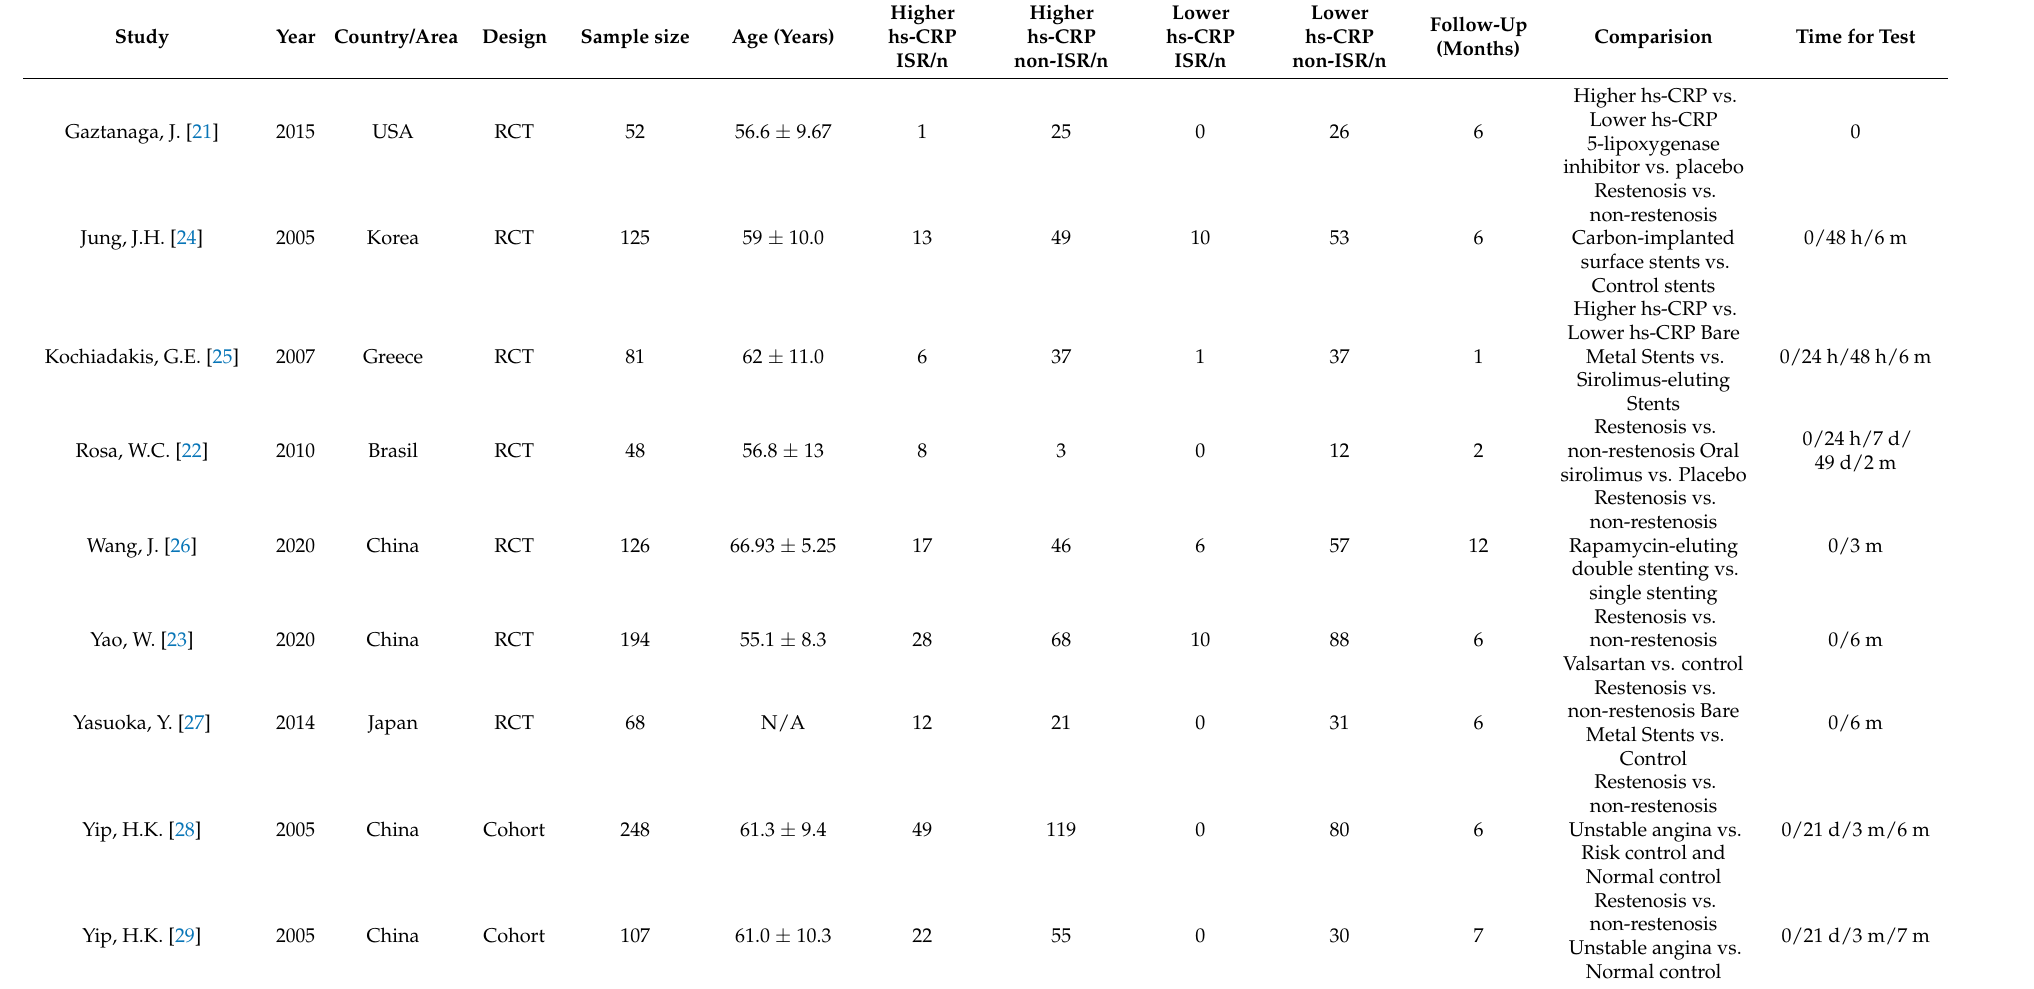
Table 1. Basic characteristics of include studies. N/A: not